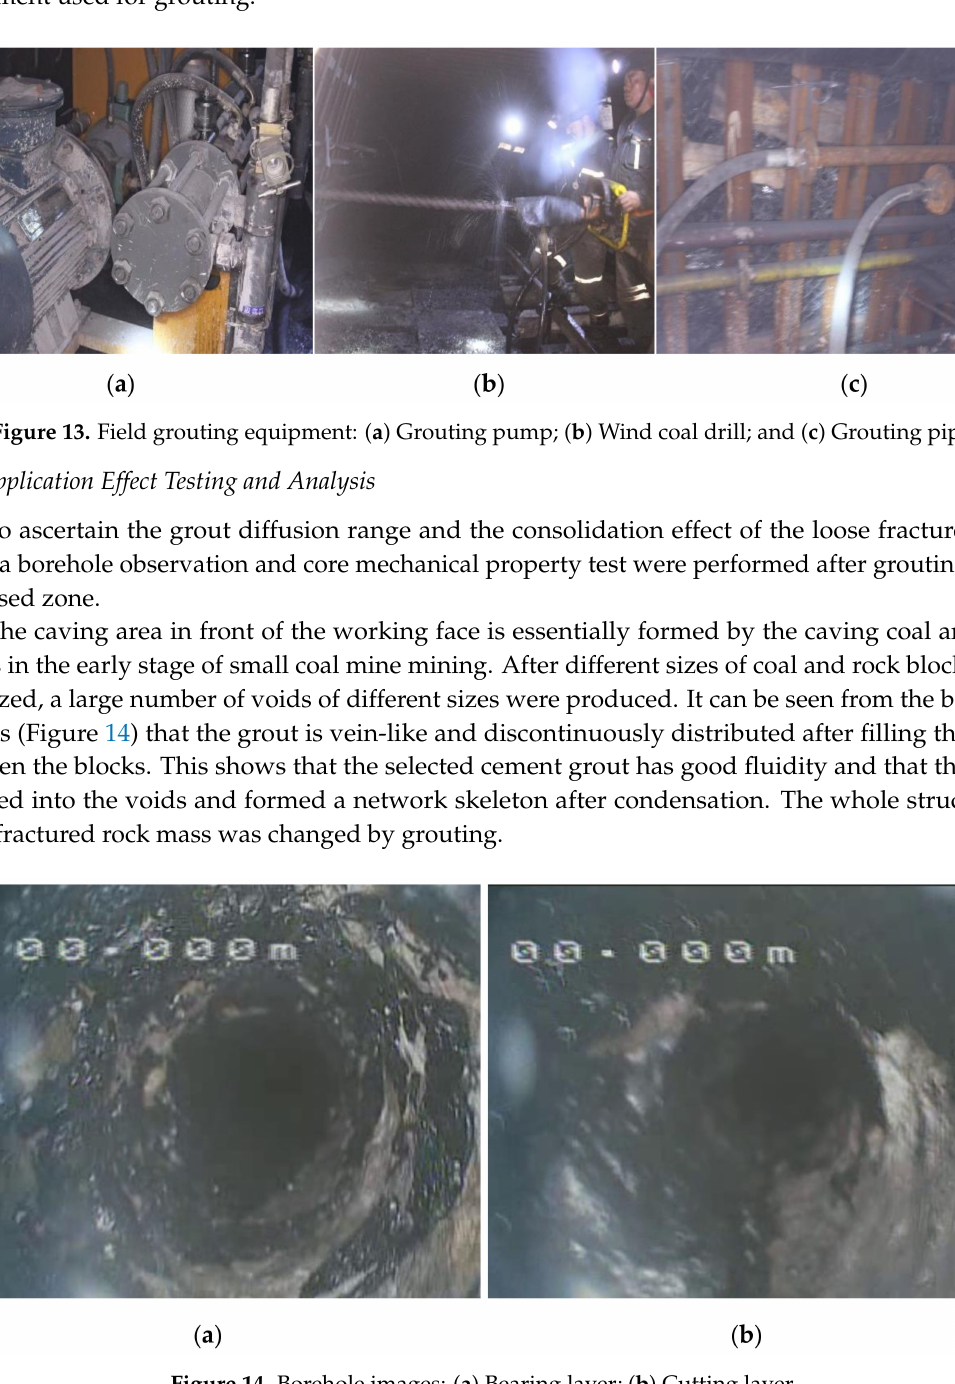
Figure 14. Borehole images: ( a ) Bearing layer; ( b ) Cutting